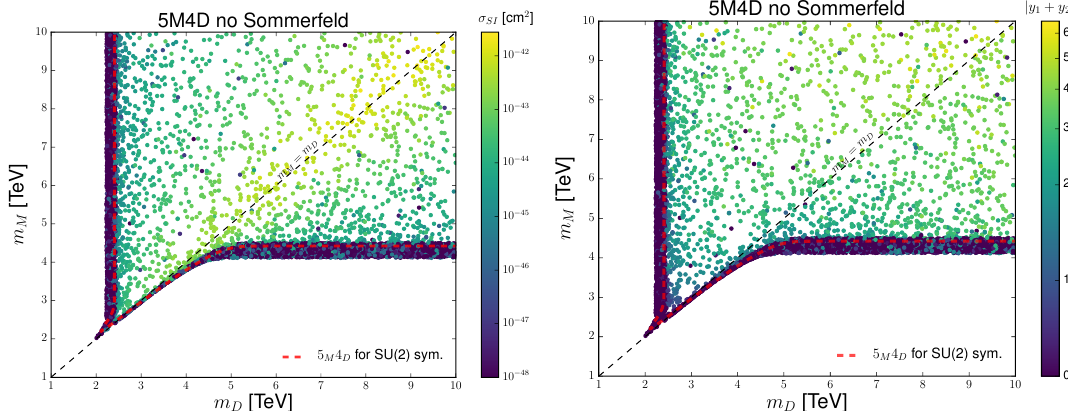
Figure 12. DM candidate parameter space in the perturbative 5M4D case for an explicit integra- tion of the dark matter abundance with micrOMEGAs in the SU(2) L -broken limit as in (cid:12)gure 8. All points give rise to (cid:10) h 2 0 : 12 and the value of the corresponding (cid:27) SI and ’ with the color code in the left and right plot respectively. With red dashed line, we show the contour obtained in the SU(2) L symmetric limit for the 5M4D case in (cid:12)gure